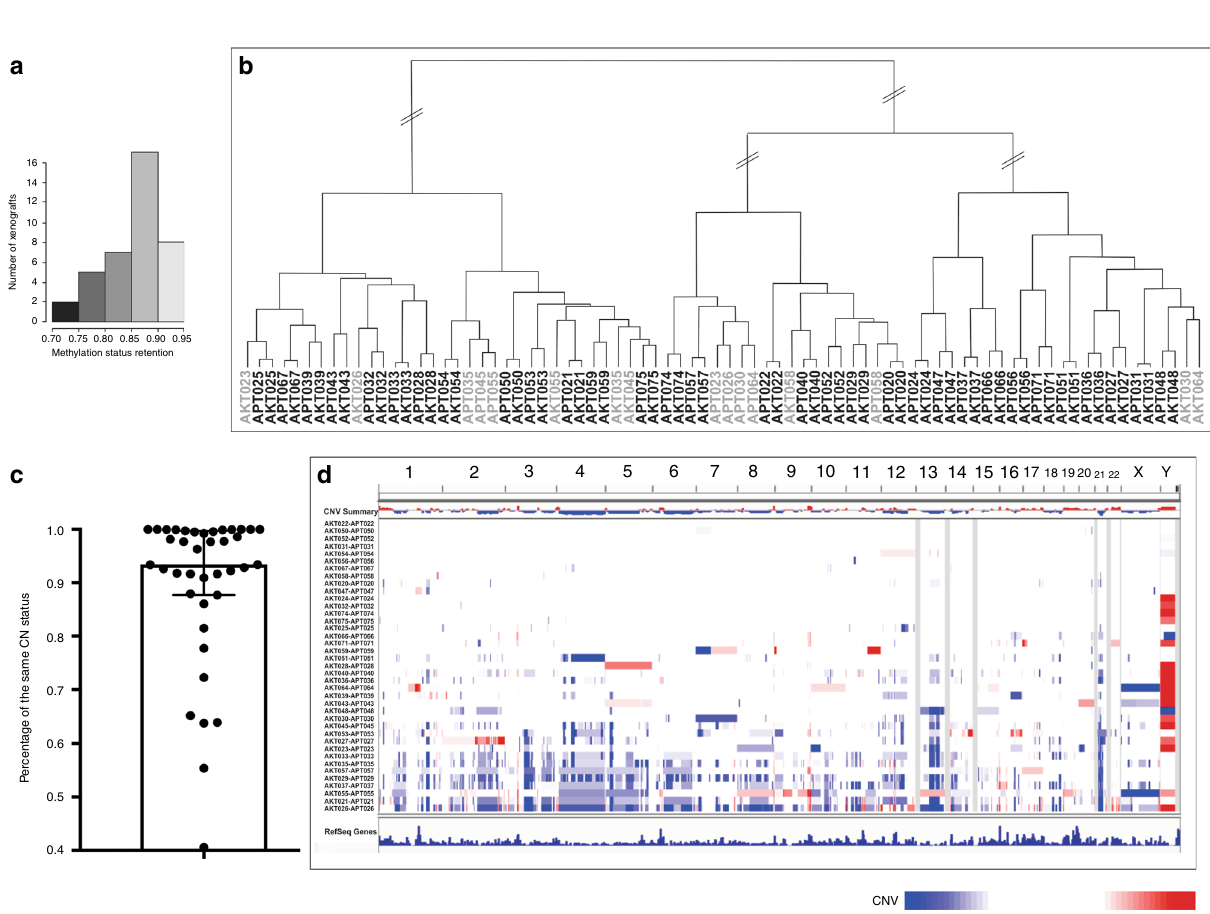
Fig. 6 Global methylation and chromosomal copy number analysis. a Methylation retention status of the WTPDX – primary WT pairs ranged from 0.7248 to 0.9167 (median 0.8678). b Hierarchical clustering of primary tumors and xenografts according to global methylation status of the top 20,000 most variable CpG site probes in the dataset resulted in the clustering of 31 of 39 xenograft – primary tumor pairs immediately adjacent to each other (matched specimens shaded in black). c Boxplot representation (median with tails representing interquartile range) of the percentage of shared copy number status between primary tumors and xenografts. d Differential genome-wide chromosomal copy number status comparing primary tumors and xenografts. Each row represents a xenograft – primary tumor pair. Chromosome numbers are given across the top. Blue indicates chromosomal copy number loss in xenografts relative to primary tumors, and red indicates copy number gain. Some xenografts (bottom of graphic) had accumulation of copy number losses (blue) compared with paired primary